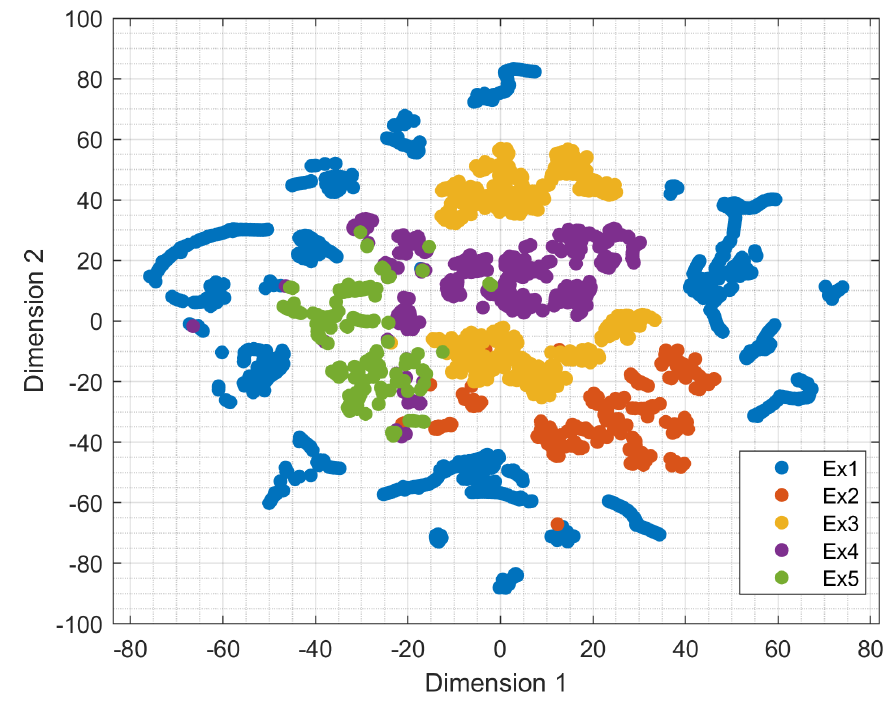
Figure 19. t-SNE plot of 5 workouts (exercises) from the KIMORE